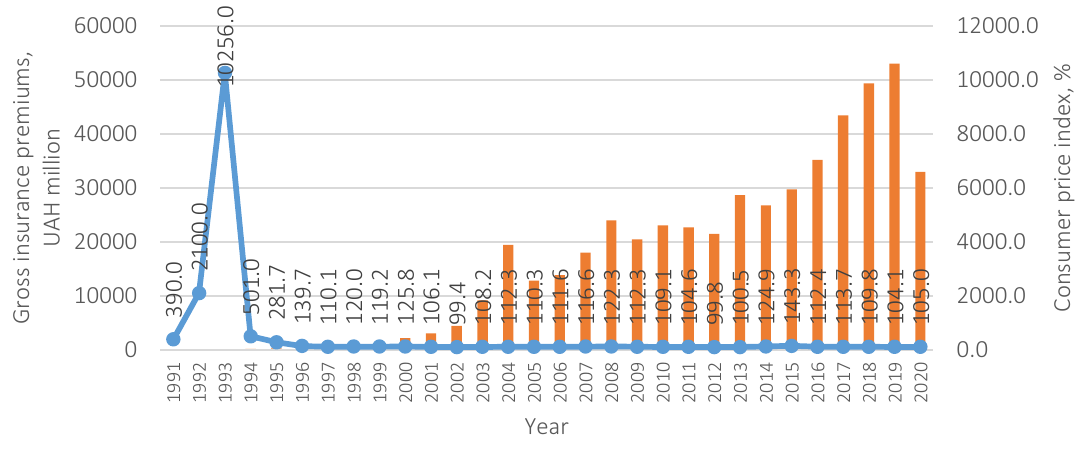
Figure 2. Gross insurance premiums and consumer price index in Ukraine in 1991–2020